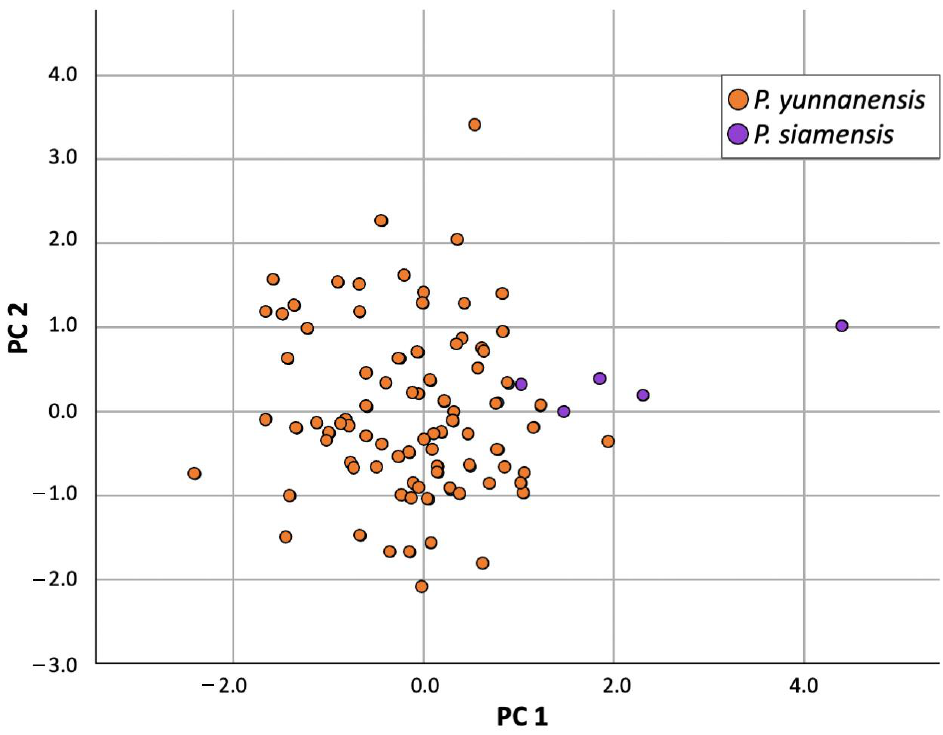
Figure 6. Principal Component Analysis results (PC1, PC2) of P. yunnanensis and P. siamensis in the flowering state.